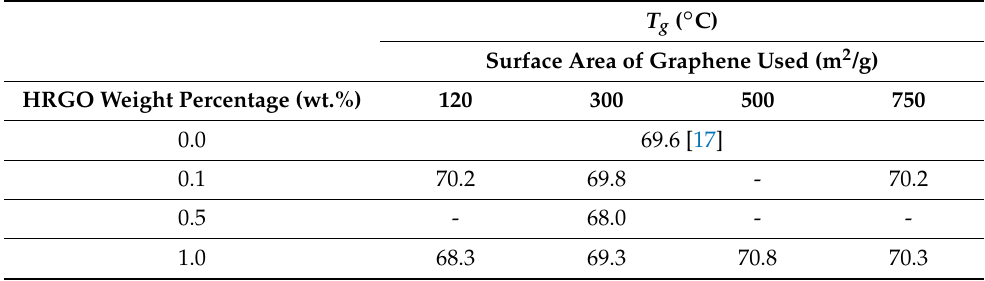
Table 5. Glass transition temperature ( T g ) versus the percentage and surface area of the added